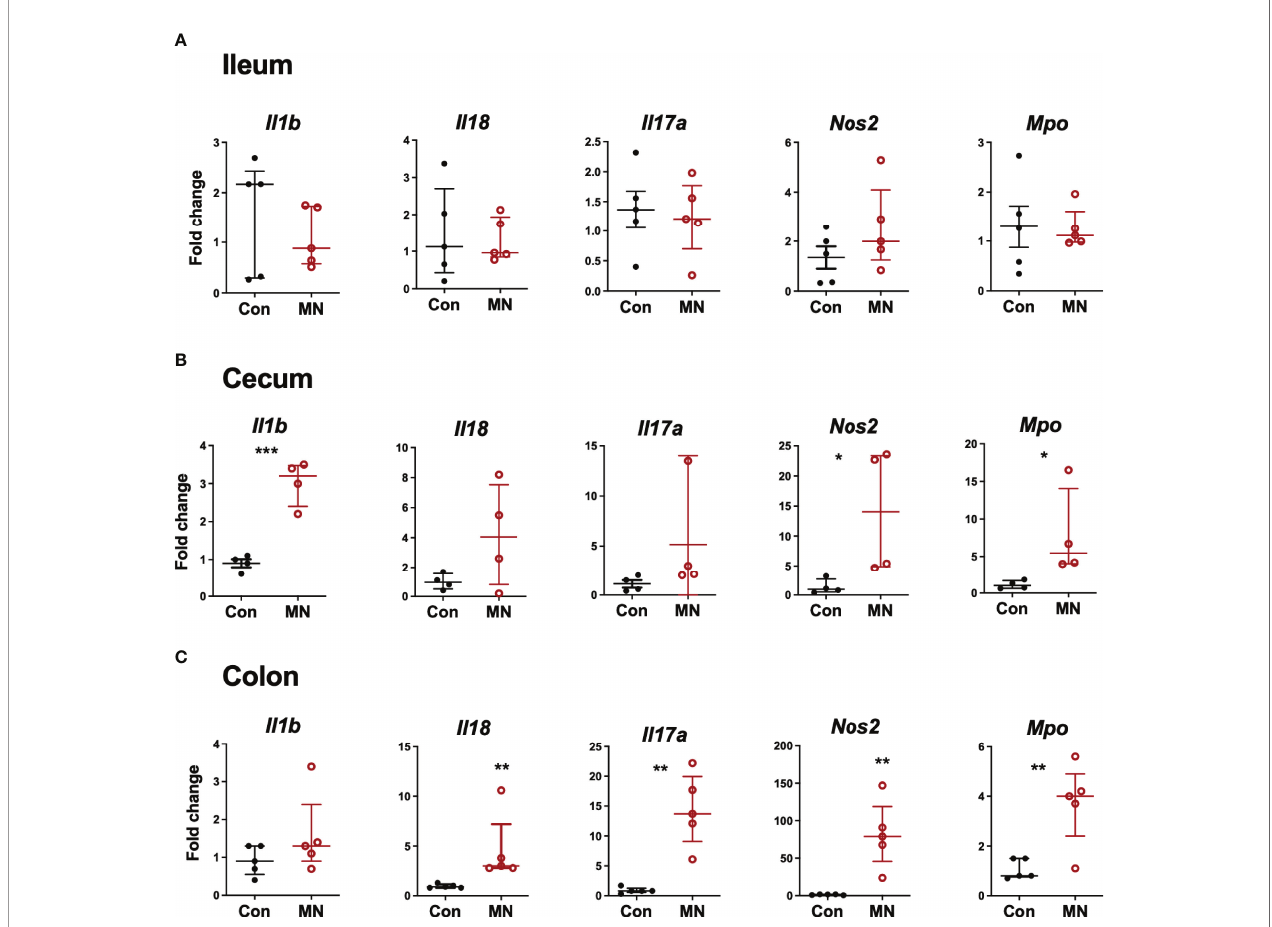
FIGURE 4 | In fl ammatory mediator expression in tissue from ileum, cecum and colon. Intestinal tissue from (A) ileum, (B) cecum, and (C) colon was harvested from control and MN mice. mRNA expression of selected in fl ammatory mediators and markers of in fl ammation was determined by qRT-PCR. Fold-change of expression in MN mice was determined relative to the mean expression in tissue from control mice. Data are presented as the median with interquartile range. (*p < 0.05; **p < 0.01; ***p <